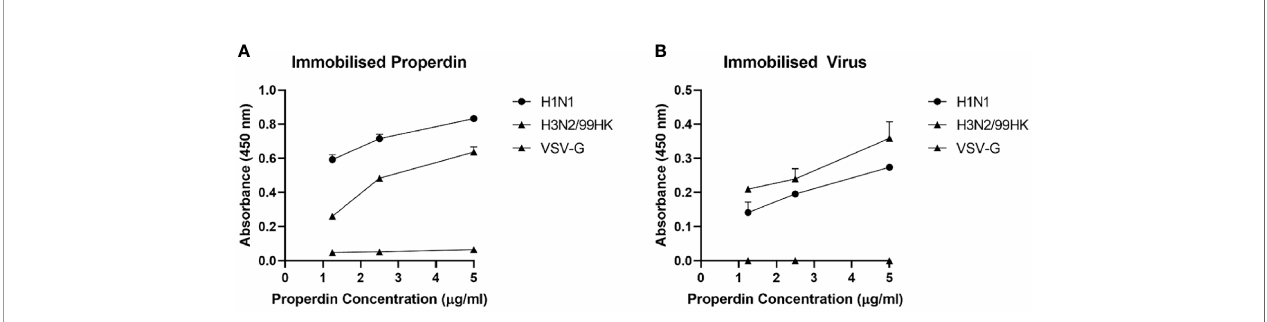
FIGURE 2 | Human properdin bound both IAV-subtypes in a dose-dependent manner. Decreasing concentration of immobilized properdin (5, 2.5 and 1.25 µg/ml) (A) or constant concentration of whole virus particles (1.36 × 106 pfu/ml) (B) were coated in a 96-well plate using Carbonate-Bicarbonate (CBC) buffer, pH 9.6 at 4°C overnight. After washing out the excess CBC buffer with PBS, three times, 20 µl of concentrated H1N1 or H3N2 (1.36 × 106 pfu/ml) (A) or decreasing concentration of properdin (5, 2.5 and 1.25 µg/ml) (B) was added to corresponding wells, followed by incubation at 37°C for 2h. The wells were probed with corresponding primary antibodies (1:5000; 100 µ/well); monoclonal anti-in fl uenza virus H1, polyclonal anti-in fl uenza virus H3, or rabbit anti-human properdin, after washing out the unbound H1N1, H3N2 or properdin. VSV-G pseudotyped lentivirus was used as a negative control and was detected using polyclonal anti-VSV-G. The data were presented as a mean of three independent experiments done in triplicates µ